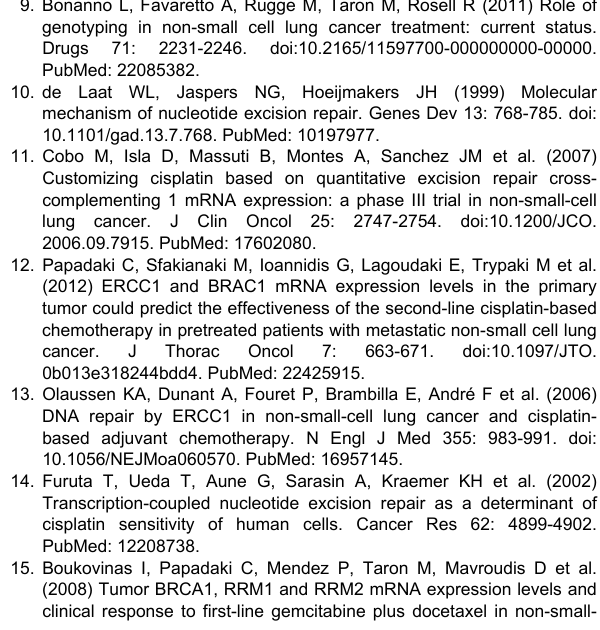
Whole patients’ population: Correlation of genes’ expression value with Progression Free Survival